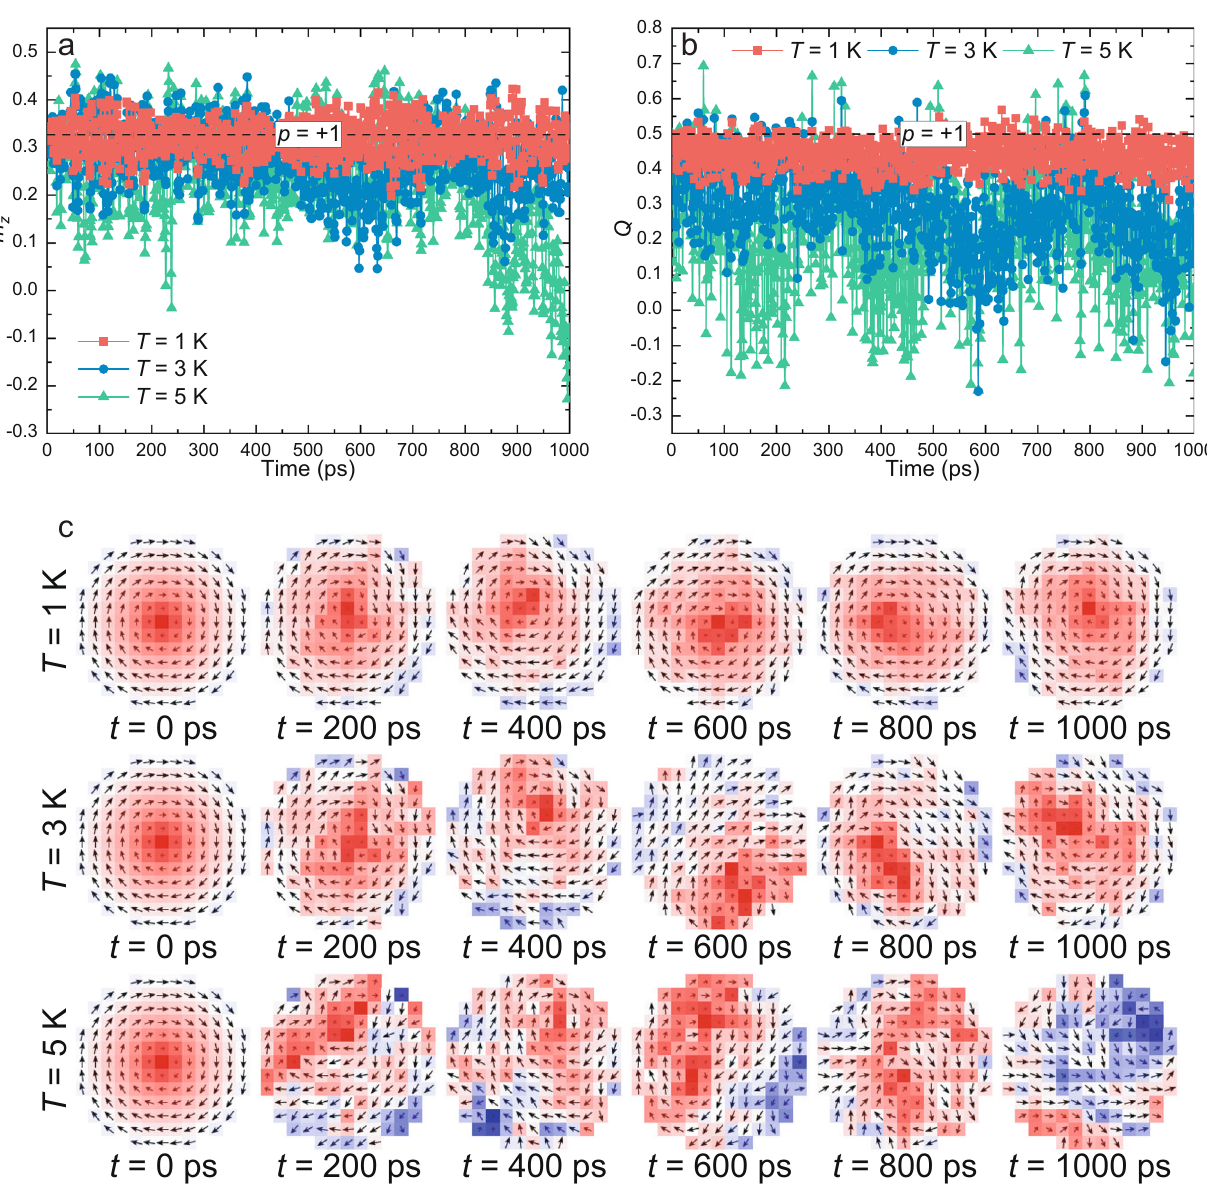
Fig. 6 The meron dynamics at fi nite temperatures. a The out-of-plane spin component m z as functions of time at different temperatures T . A relaxed meron with p = + 1 is placed at the nanodisk with n = 7 at t = 0 ps. The thermal fl uctuations reduce the stability of the meron state. b The topological charge of the system Q as functions of time at different temperatures. For a relaxed meron at zero temperature, the topological charge equals 0.5. c Selected top-view snapshots of the spin con fi gurations in the nanodisk at different temperatures. The radius of the meron is n = 7, and the damping parameter α = 0.1. The simulation parameters are given in the caption of Fig. 2. More details are given in the “ Methods ”